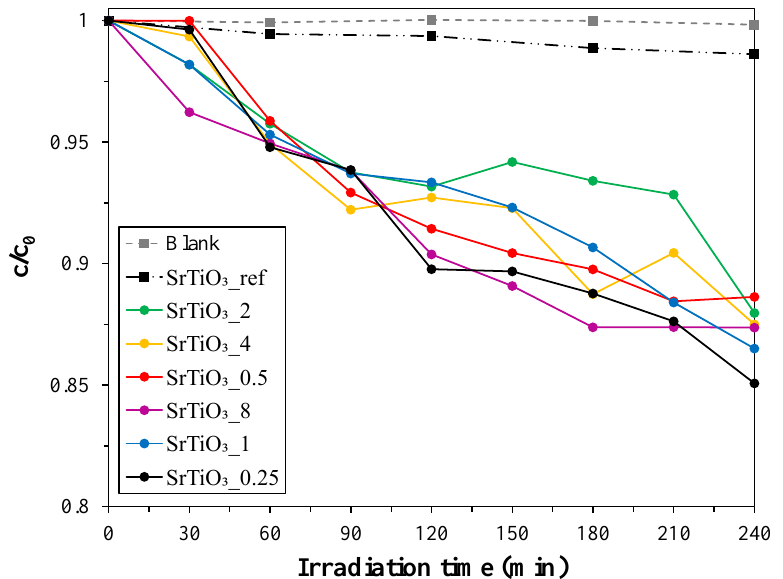
Figure 4. Degradation curves of phenol for SrTiO 3 photocatalysts prepared at various EG:H 2 O ratios.